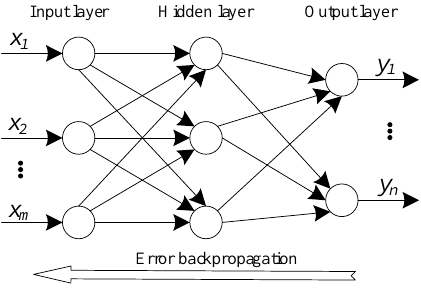
Figure 11. Diagram of BPNN.